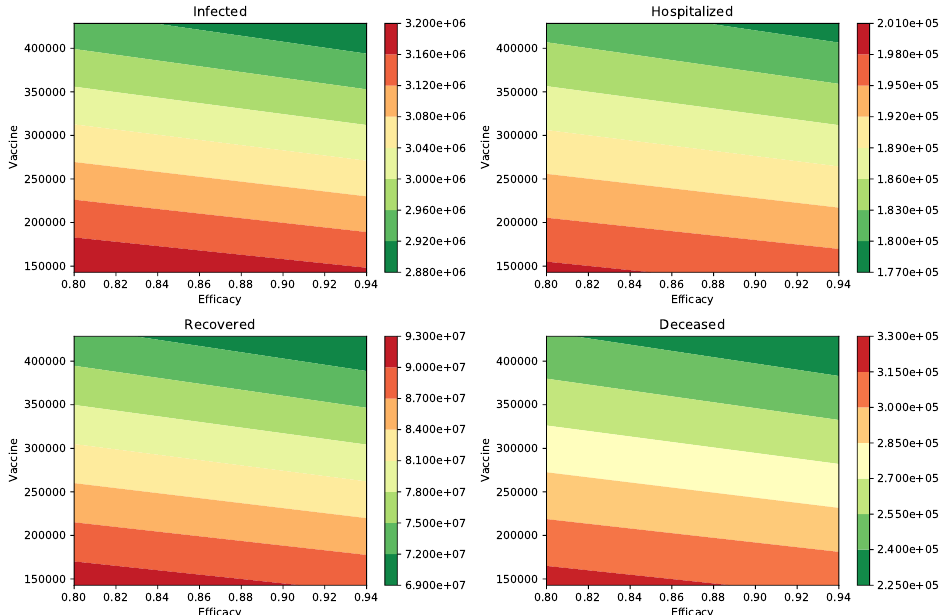
Figure 5. Impact of the inoculation rate and efficacy of the vaccine on the peak of the infected (I) and hospitalized (H) subpopulations. In addition, on the deaths (D) and recovered (R) cases. In these scenarios, the infectiousness of the asymptomatic individuals relative to symptomatic is 75% ( β A = β I ), and the percentage of infections that are asymptomatic is 40%. In all these scenarios the transmission rate is β =